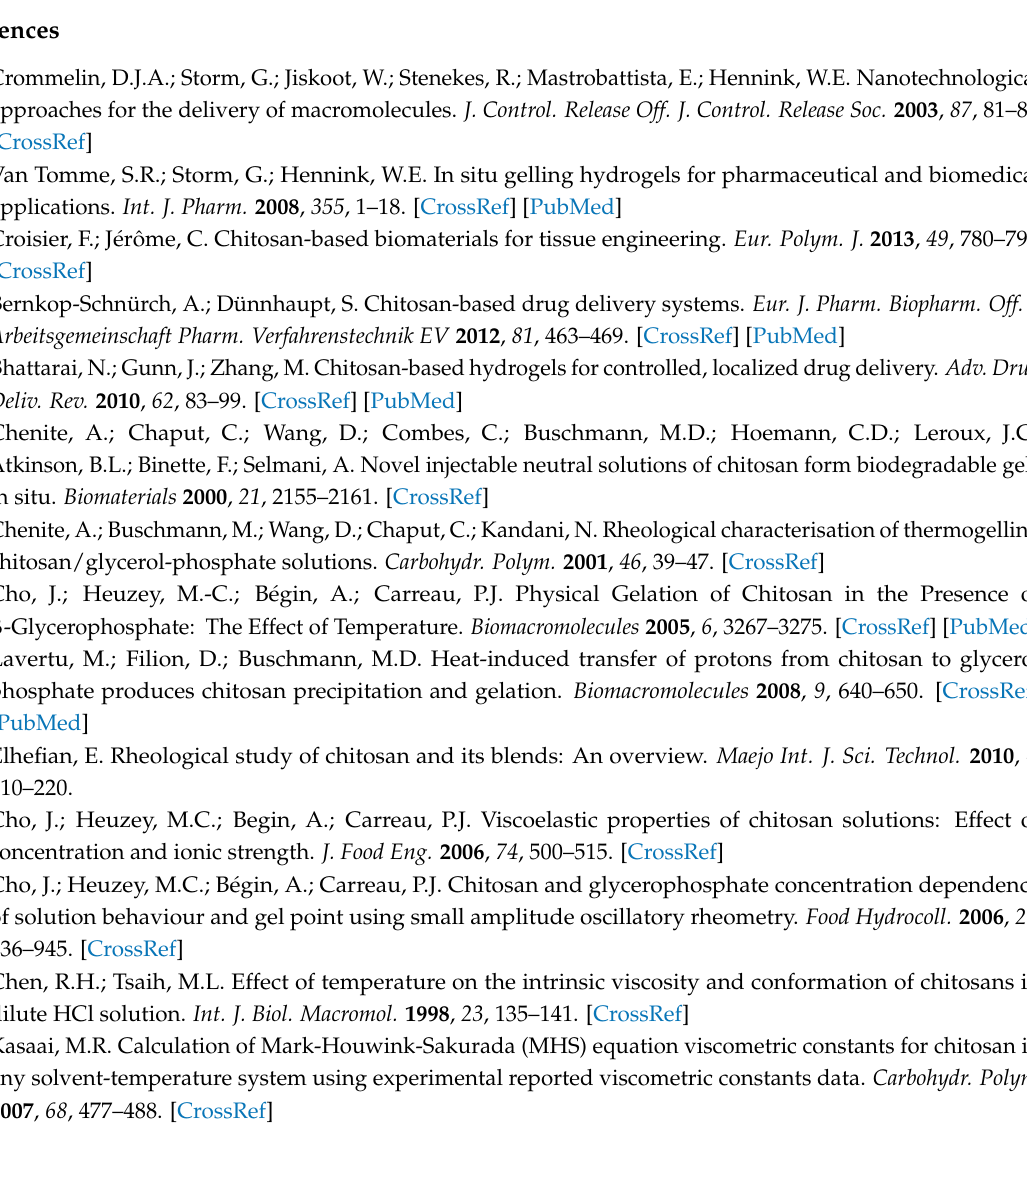
Figure S1: Schematic presentation of Rheo-SALS system; Figure S2: Schematic presentation of measurement systems: double gap and plate-plate. The top view on sample plane shows different measurement